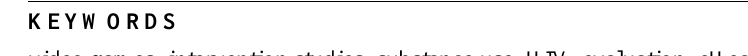
video games; intervention studies; substance use; HIV; evaluation;